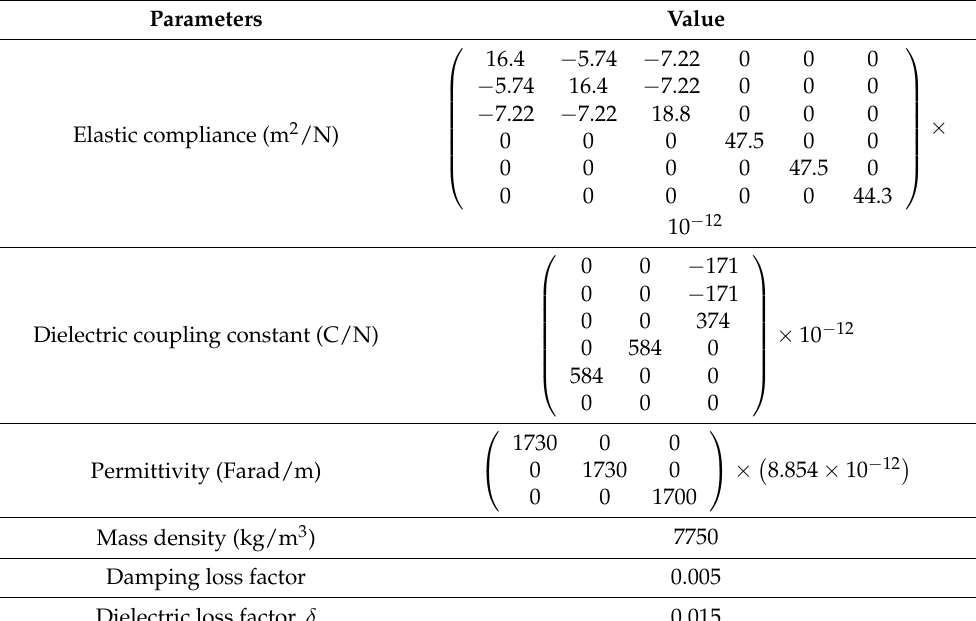
Table 2. Piezoelectric properties of the PZT-5A